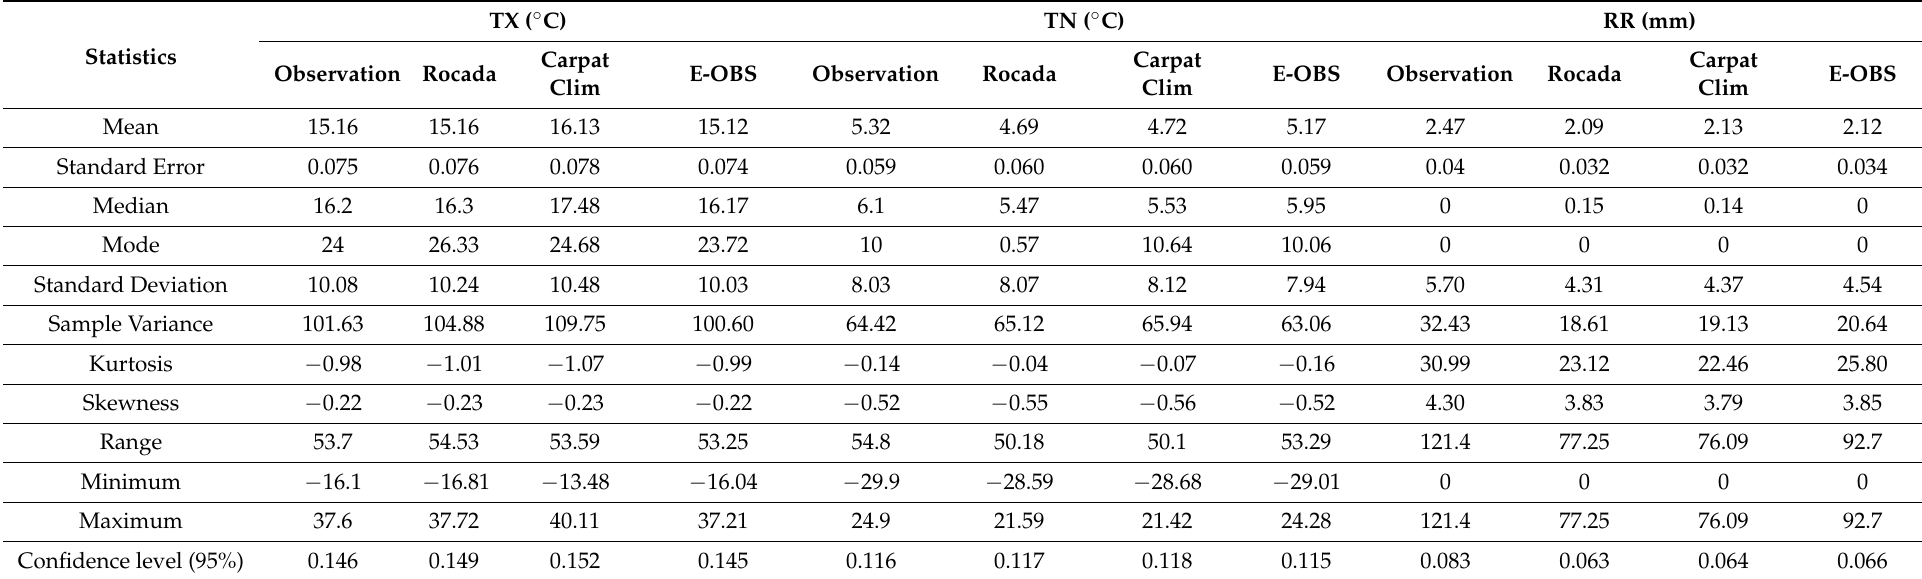
Table 2. Descriptive statistics for the Baia Mare Meteorological